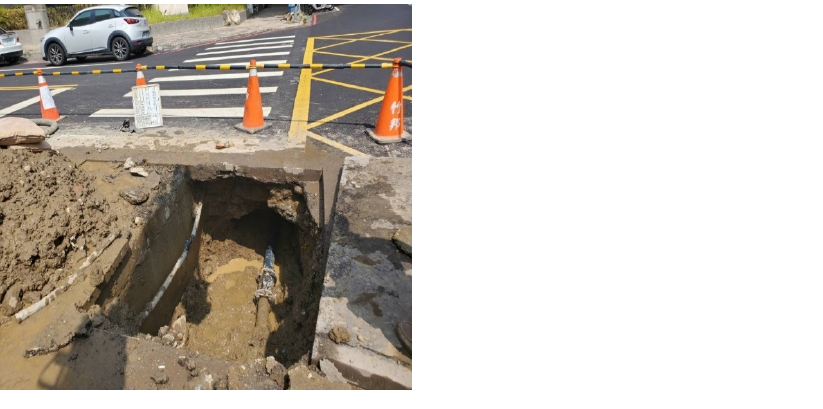
Figure 18. Factory personnel conducted excavation verification of markings.